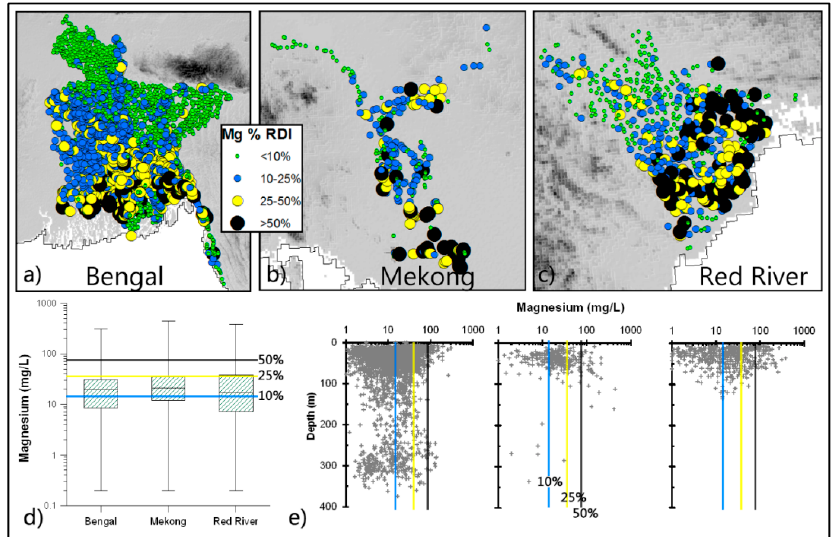
Figure 3. Concentration of Mg in groundwater in relation to RDI. ( a – c ) spatial and ( e ) vertical variations of well-water Mg, and ( d ) basic statistical properties (as Figure 2) of well-water Mg are shown in the box plots.